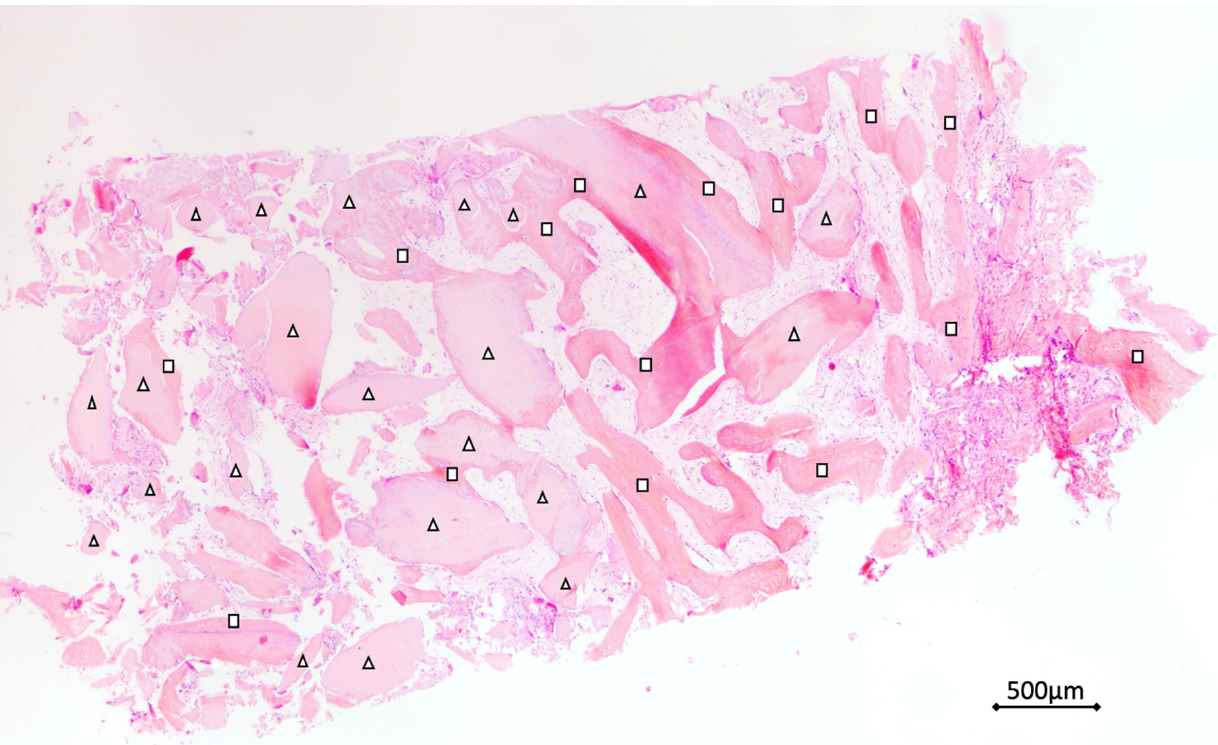
Figure 4. Biopsies istological and histomorphometrical analysis. (Hematoxylin and eosin colored). Total bone volume (BV), residual graft material (RG) and new bone (NB) were evaluated. With the triangle, the dentin/enamel granules (RG), and with the square the new bone (NB) were indicated.